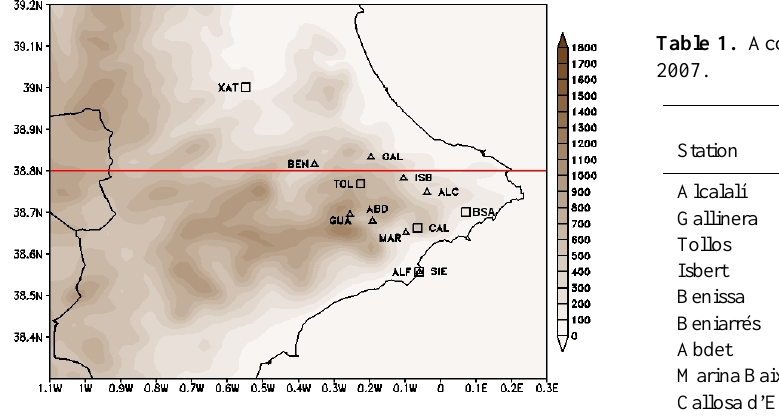
Fig. 5. Location of the meteorological stations in Table 1 and loca- tion of vertical cross sections on RAMS Grid 4.